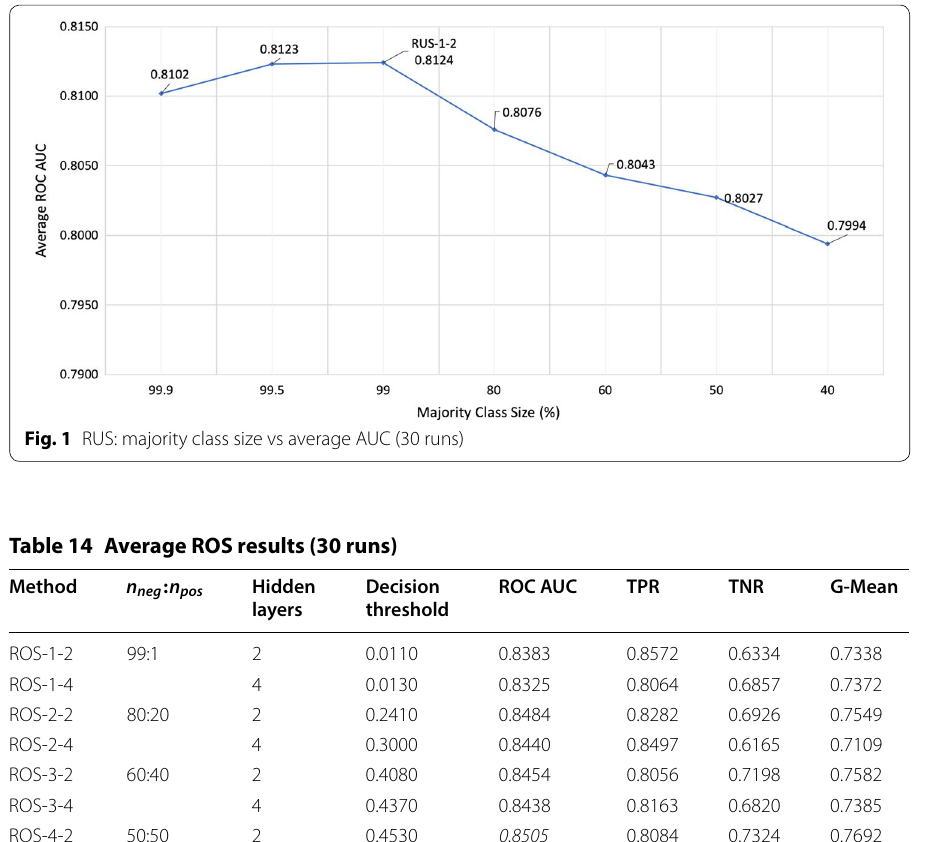
Italic font indicates the maximum ROC AUC score